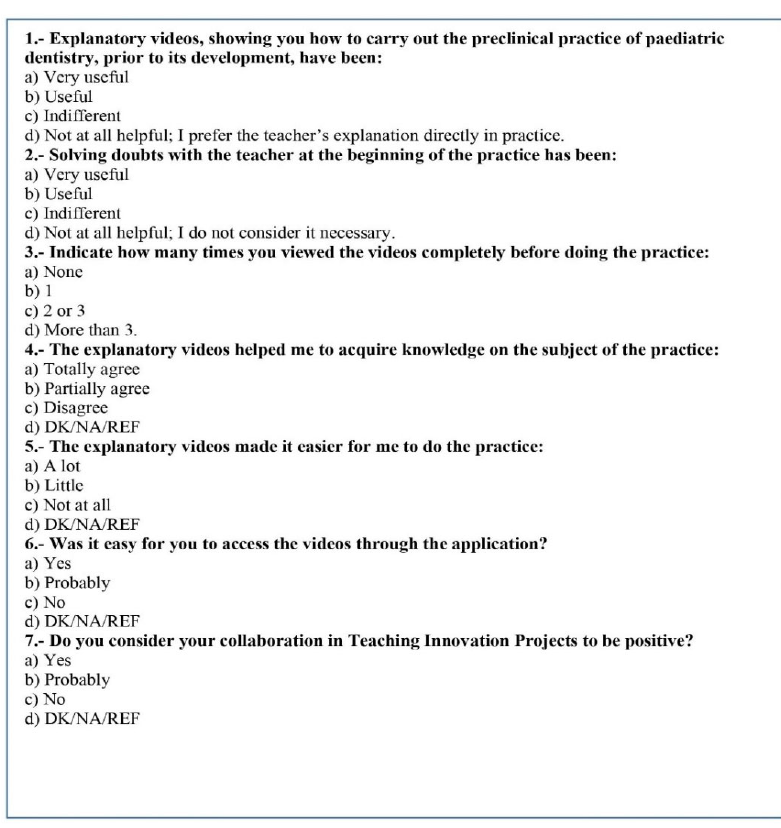
Figure 1. Satisfaction survey. Table 2. Evaluation